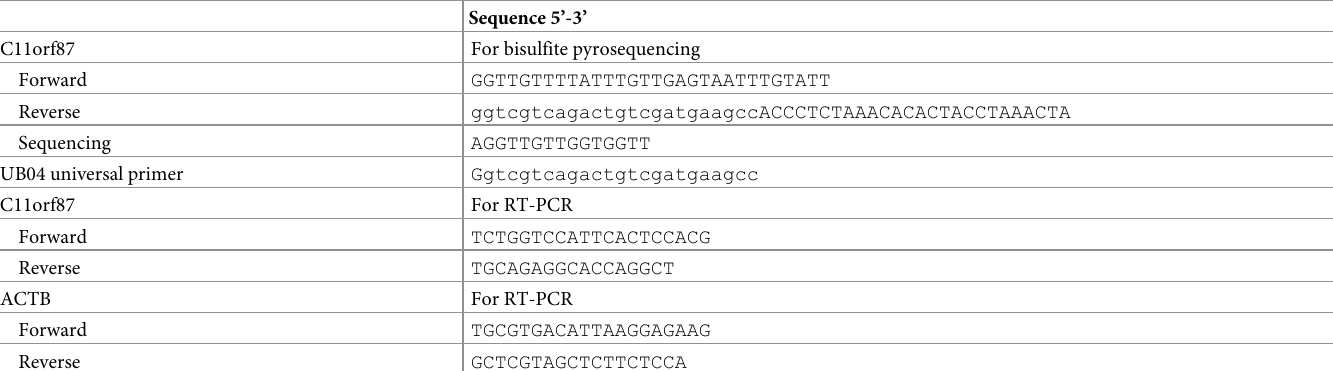
Table 2. Primer sequences used in this